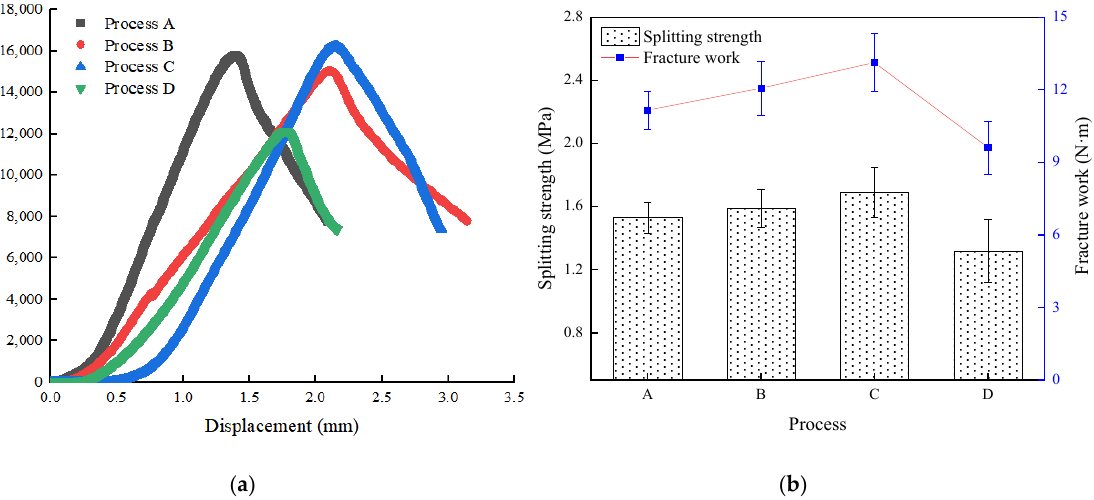
Figure 9. Results of indirect tensile test: ( a ) load–displacement curves; ( b ) fiber mixing processes and splitting strength or fracture work.